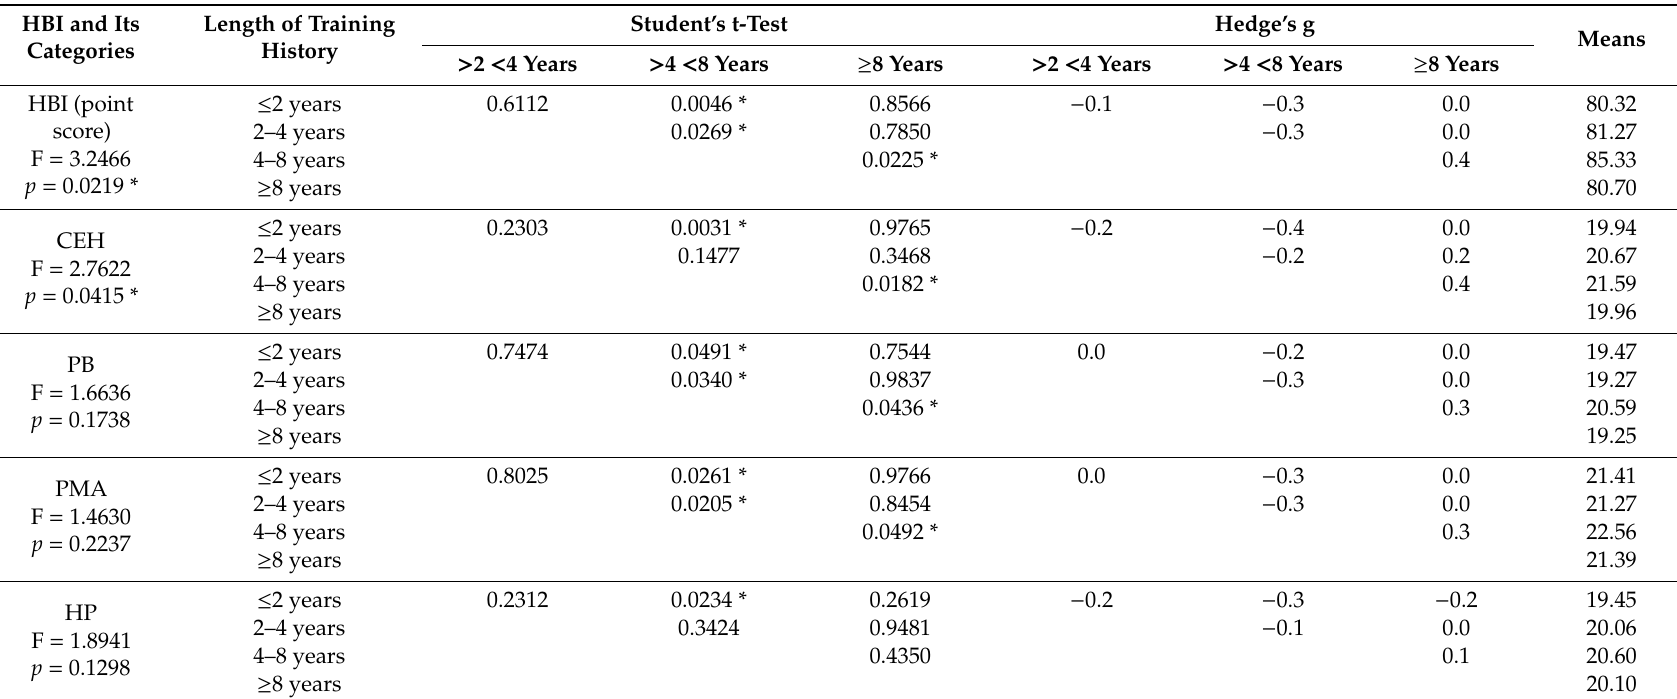
Table 3. Health behaviors of respondents with varied length of training history (F-test, Student’s t-test, Hedge’s